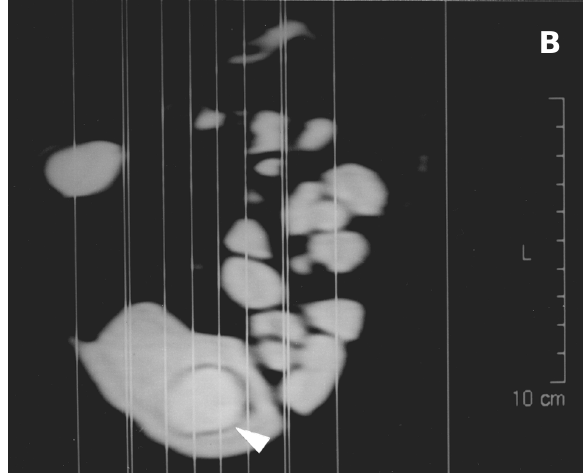
Figure 1 B – Weighted image in T2, in frontal plane. The illus- trative arrow shows a rounded image with regular contours, in the interior of bladder, corresponding to